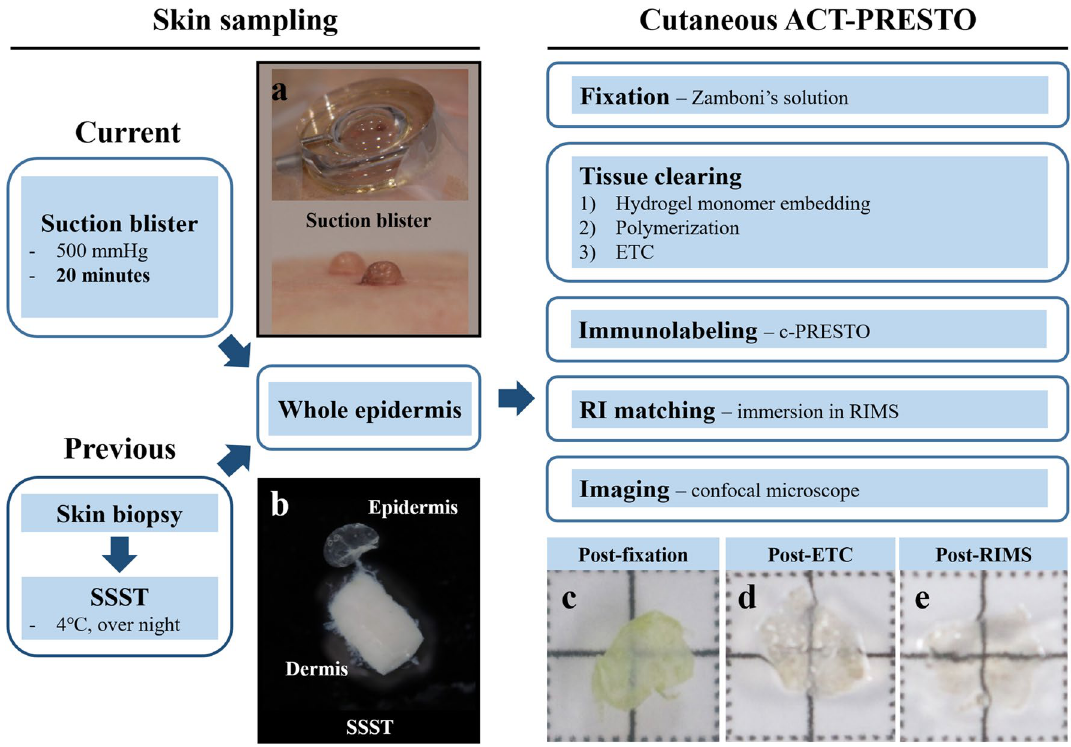
Figure 1. Summarized processes of advanced skin-clearing protocol. The epidermis was separated from the dermis using the ( a ) suction blister method instead of ( b ) a previously adopted SSST 8 . The separated epidermis subsequently proceeded to the cutaneous ACT-PRESTO procedures, including ( c ) fixation, ( d ) electrophoretic tissue clearing (ETC), and ( e ) RI matching. SSST Salt-split skin test, ACT Active clarity technique, PRESTO Pressure-related efficient and stable transfer of macromolecules into organs, RI Reflective index, RIMS Reflective index matching